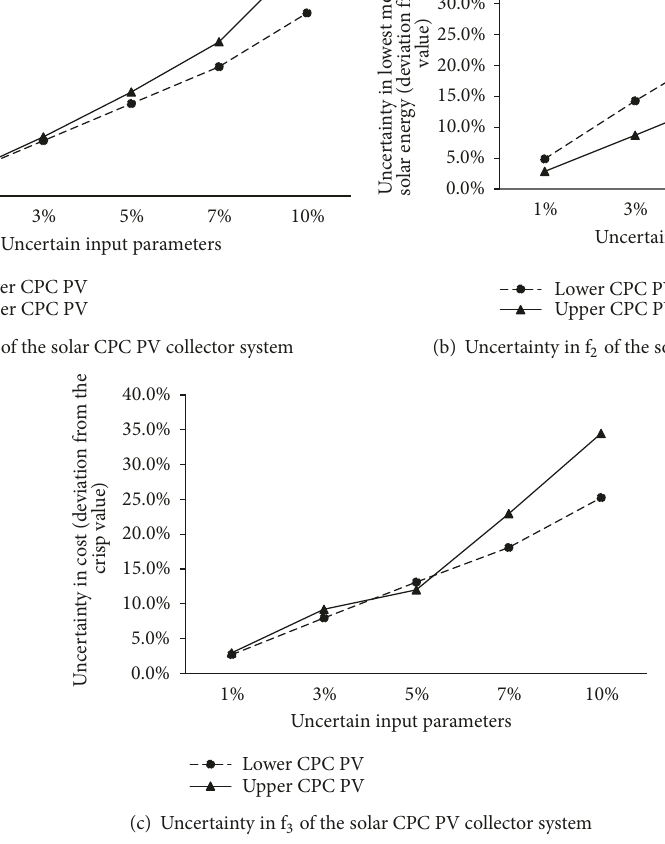
% in the lower bound and 1.46 % in the upper bound.